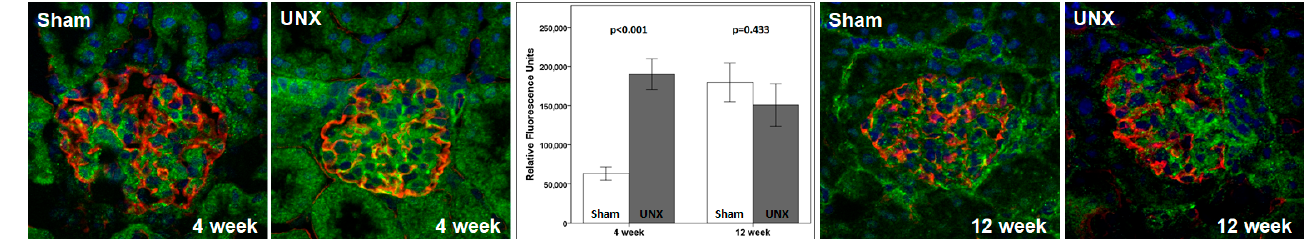
Figure 4. Confocal microscopy images show an increased expression of β -galactosidase (green fluorescence) as the relative fluorescence units/area at 4 weeks but not at 12 weeks (Table 2). Podocalyxin (red fluorescence) identifies the podocytes within the glomerulus. Unilateral nephrectomy is associated with glomerular hypertrophy. The bar graph shows the net relative fluorescence units/glomerulus.